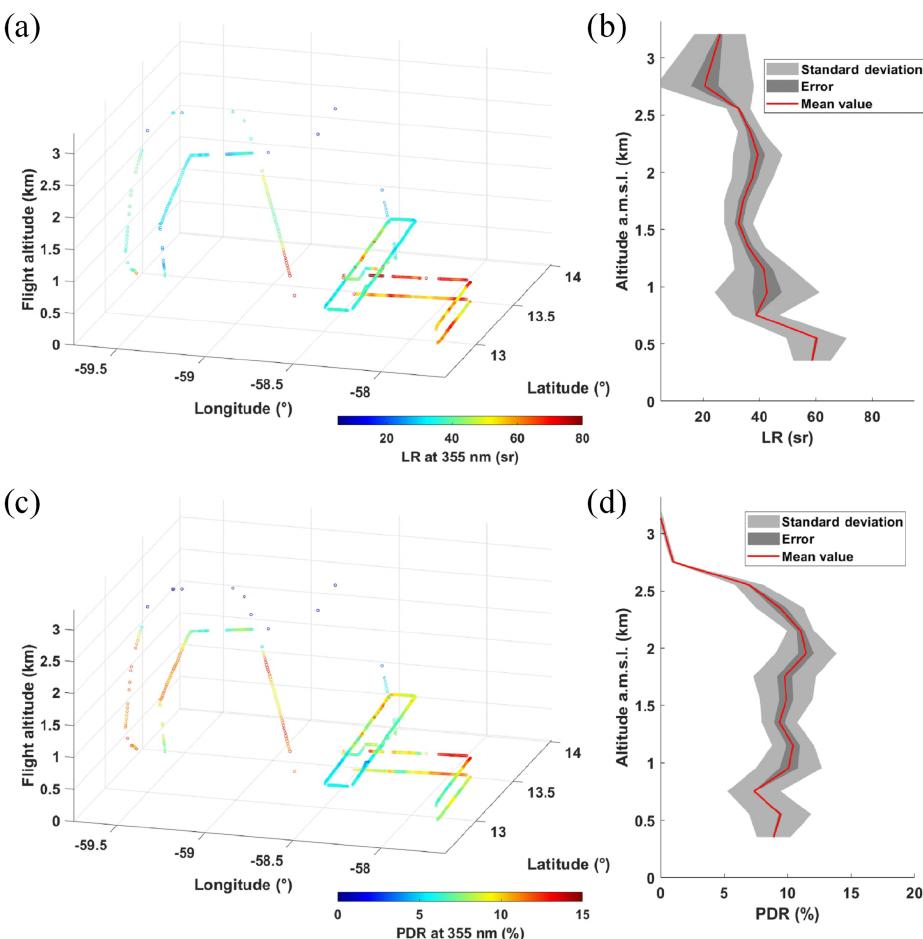
Figure 6. (a) Lidar ratio (LR) derived from ALiAS measurements during the flight F10 on 2 February 2020 at 19:45–21:00UTC; (b) cor- responding vertical profile of the LR which shows the spread of measurements via the standard deviation (light-grey area) and the statistical error (dark-grey area). The same types of figures are given for the particle depolarization ratio (PDR) in panels (c) and (d) ,